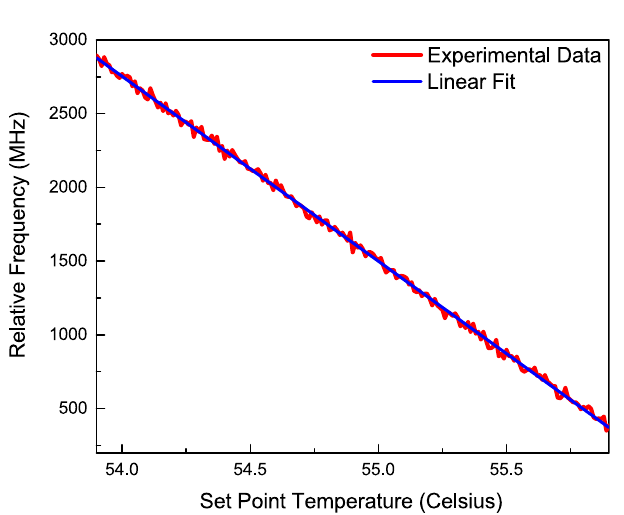
Figure 10. Optical response of PSFBG-F-FBG resonator, plotted versus the set point